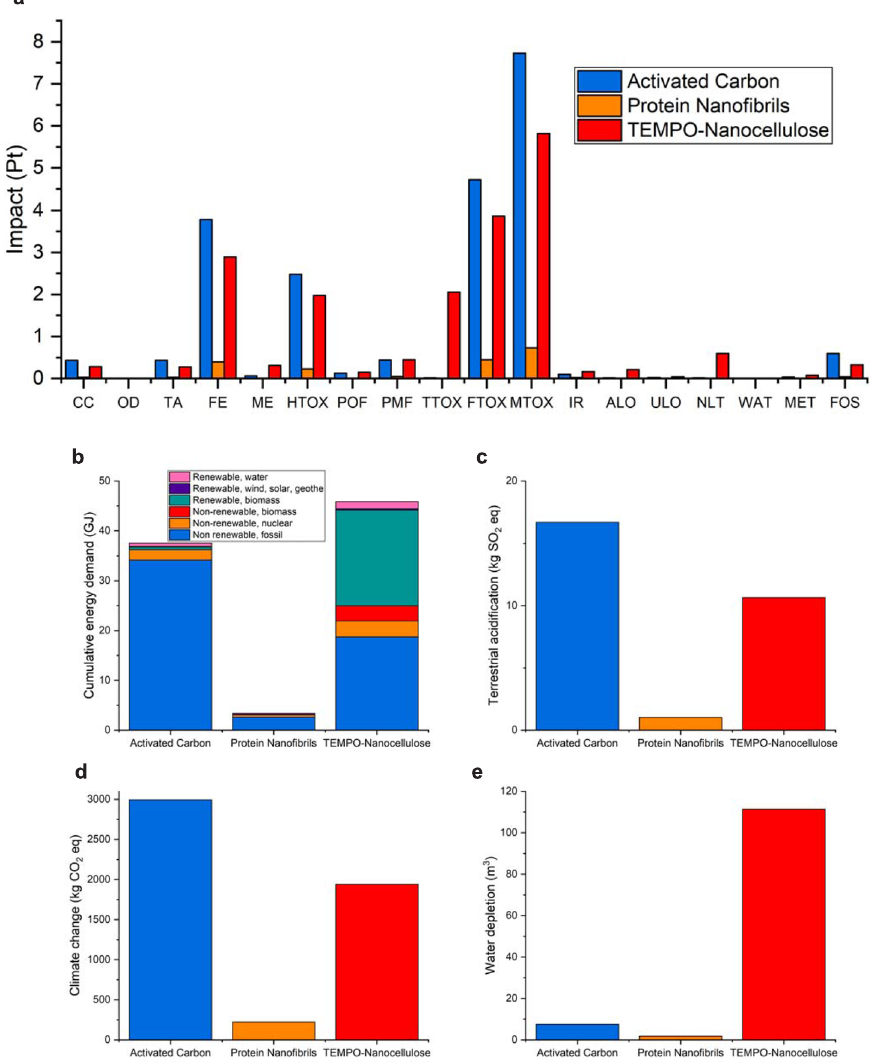
Fig. 6 LCA of Protein nano fi brils compared to nanocellulose and activated carbon to remove lead from water. a Normalized environmental impact pro fi le of application of protein nano fi brils, nanocellulose, and activated carbon for purifying water from lead, comprising all 18 impact categories of the ReciPe method (CC climate change, OD ozone depletion, TA terrestrial acidi fi cation, FE freshwater eutrophication, ME marine eutrophication, HTOX human toxicity, POF photochemical oxidant formation, PMF particulate matter formation, TTOX terrestrial ecotoxicity, FTOX freshwater